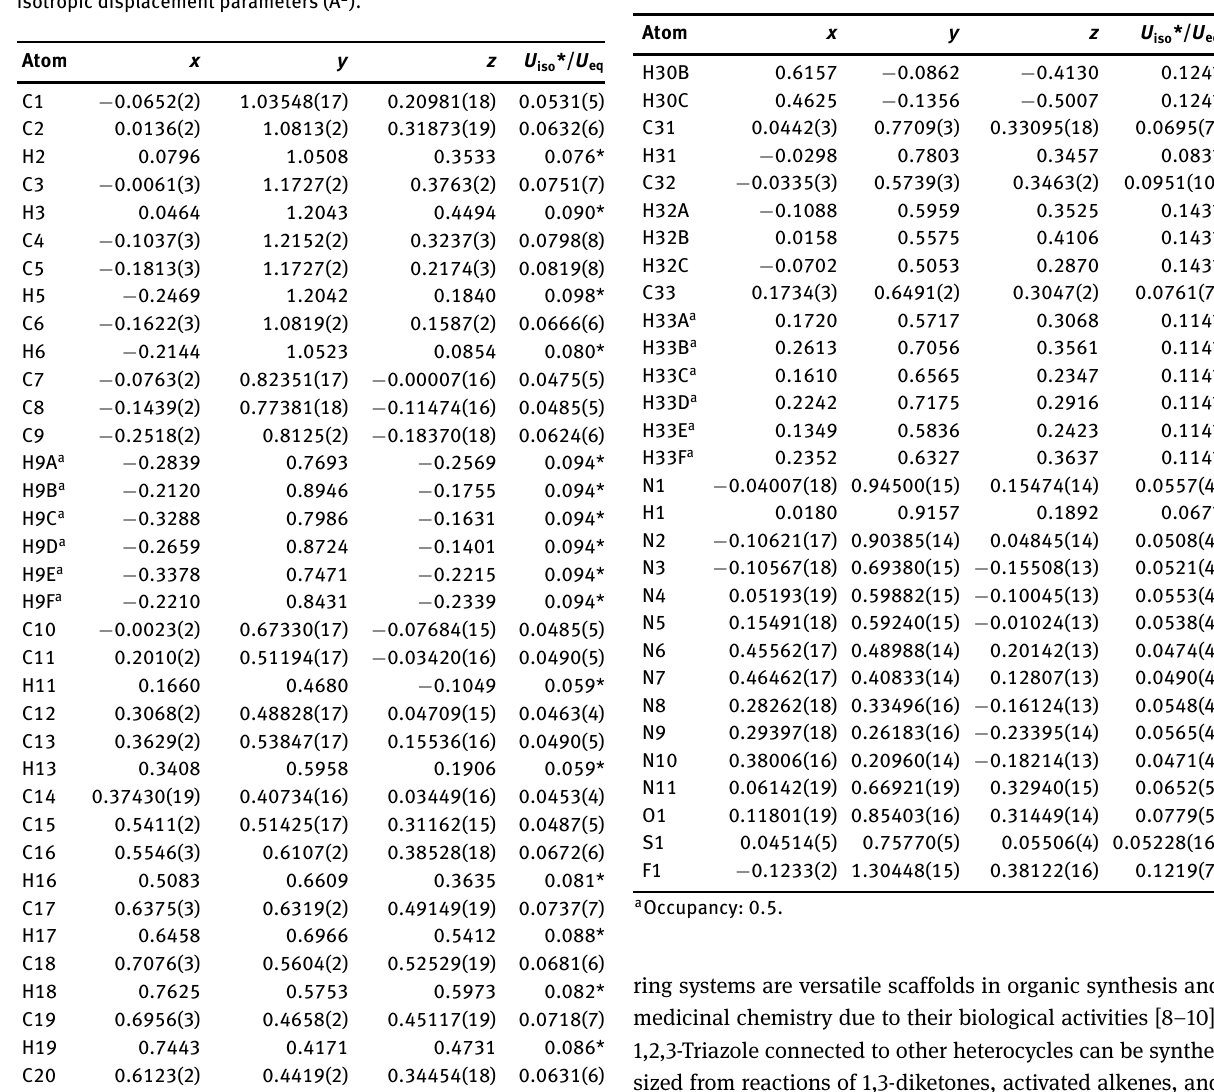
Table 2: Fractional atomic coordinates and isotropic or equivalent isotropic displacement parameters (Å 2